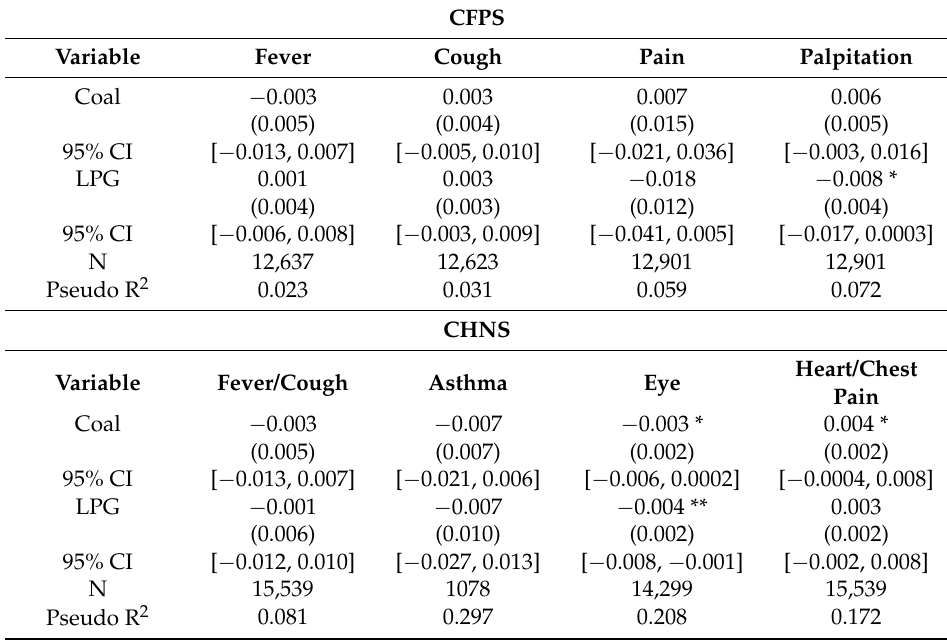
Table 8. Probit estimates for the effect of domestic cooking fuels on women’s health (specific symptoms) in rural areas: CFPS 2010–2012 & CHNS